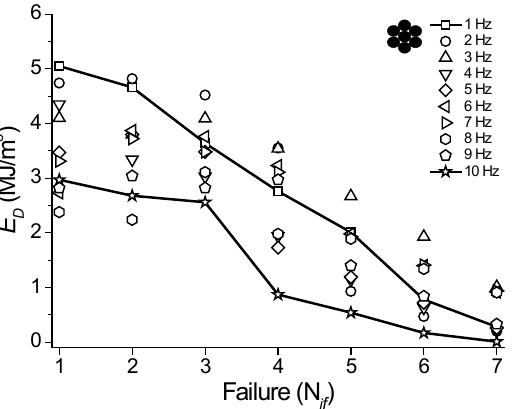
Figure 19. Dissipated energy evolution with the failure cycles for the loading frequencies from 1 Hz to 10 Hz for the NiTi SMA micro cable.